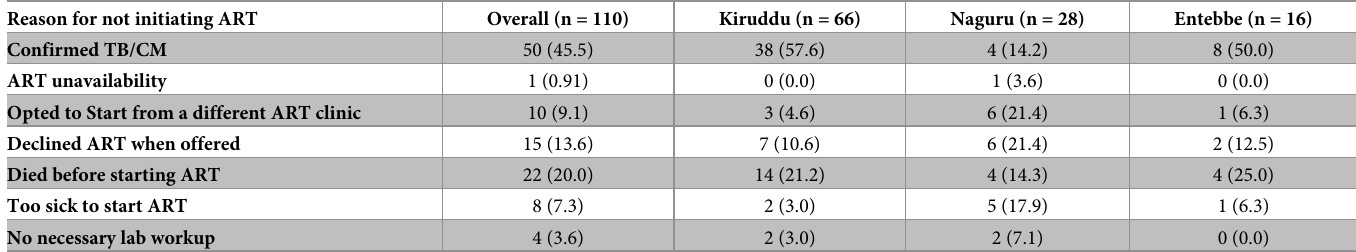
Table 3. Reasons for not initiating ART during hospitalization stratified by study site.